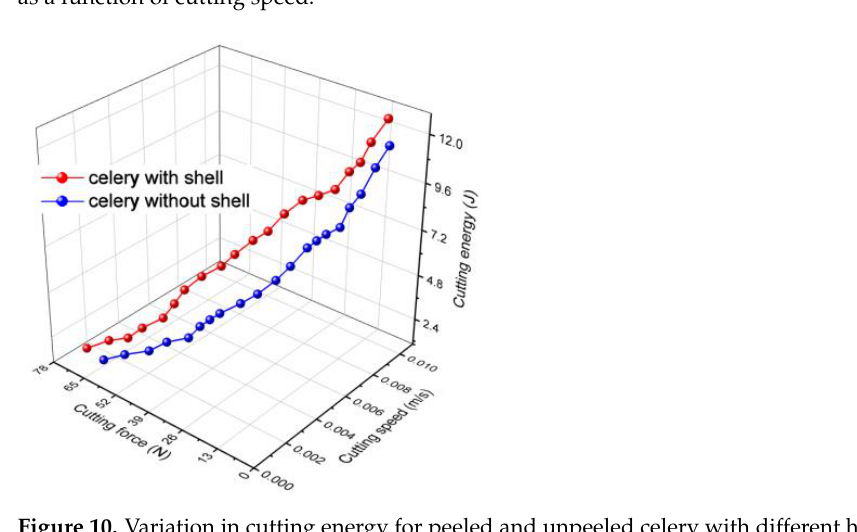
Figure 10. Variation in cutting energy for peeled and unpeeled celery with different humidity levels as a function of cutting speed.